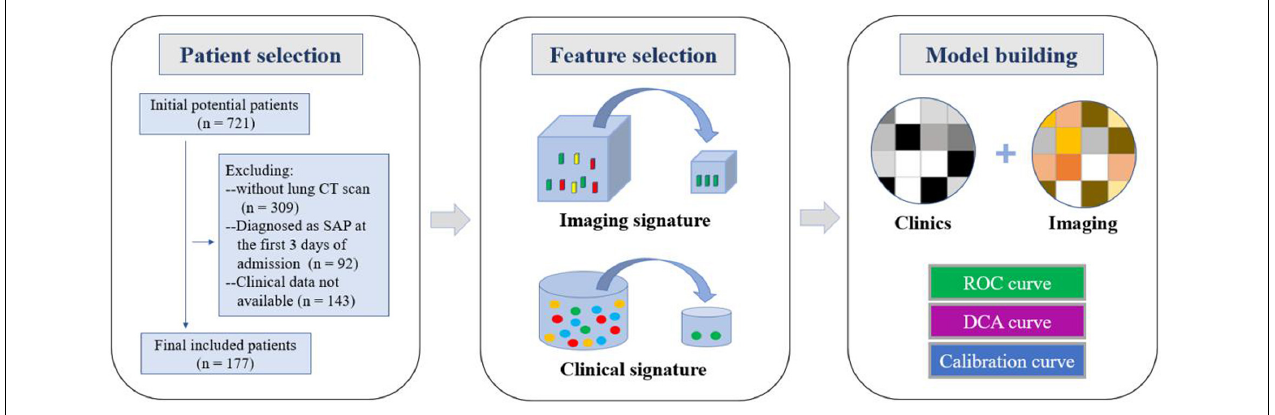
FIGURE 1 | Workflow of the study. Workflow can be divided into three parts:patient selection, feature extraction, and model construction.